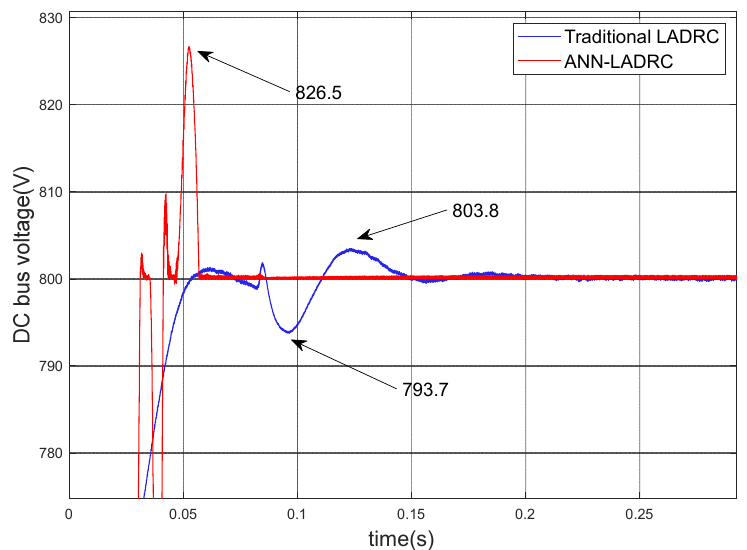
Figure 9. Initial control bus voltage waveform.